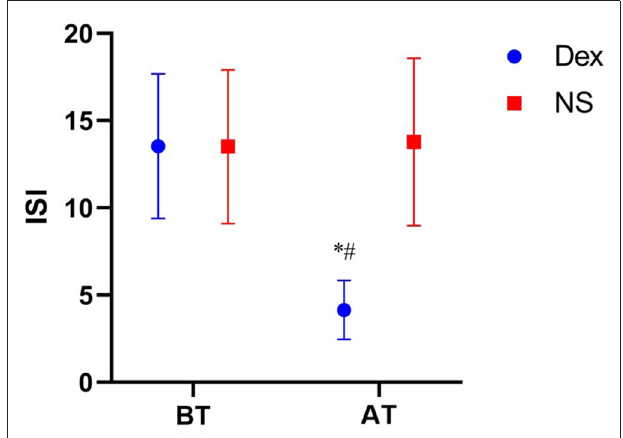
FIGURE 2 | Comparison of ISI scores in two groups at different time points. BT, Before treatment; AT, After treatment; ISI, Insomnia severity index; Dex, Intranasal dexmedetomidine group; NS, Intranasal normal saline group. ISI score comparison of Dex group before and after treatment, P < 0.01 vs. *. Comparison of ISI score between Dex group and NS group after treatment, P < 0.01 vs. # .